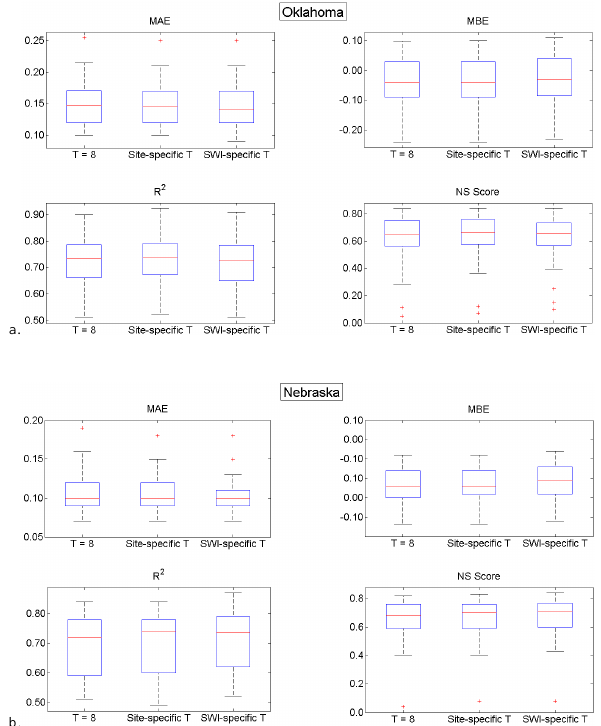
Figure 10 . Box plots of error metrics for the estimated root-zone soil moisture averaged over all Fig. 10. Box plots of error metrics for the estimated root zone soil (a) Oklahoma and (b) Nebraska sites. Each boxplot is generated from estimates made with one of three different optimum T parameters. moisture averaged over all (a) Oklahoma and (b) Nebraska sites. Each box plot is generated from estimates made with one of three different optimum T